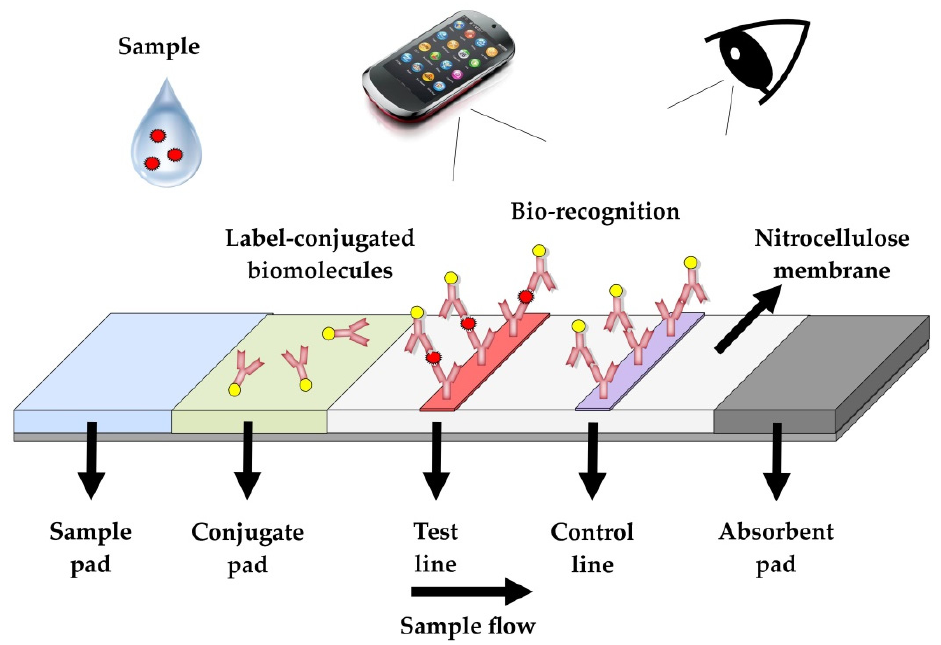
Figure 1. Principle of LFA sandwich format.